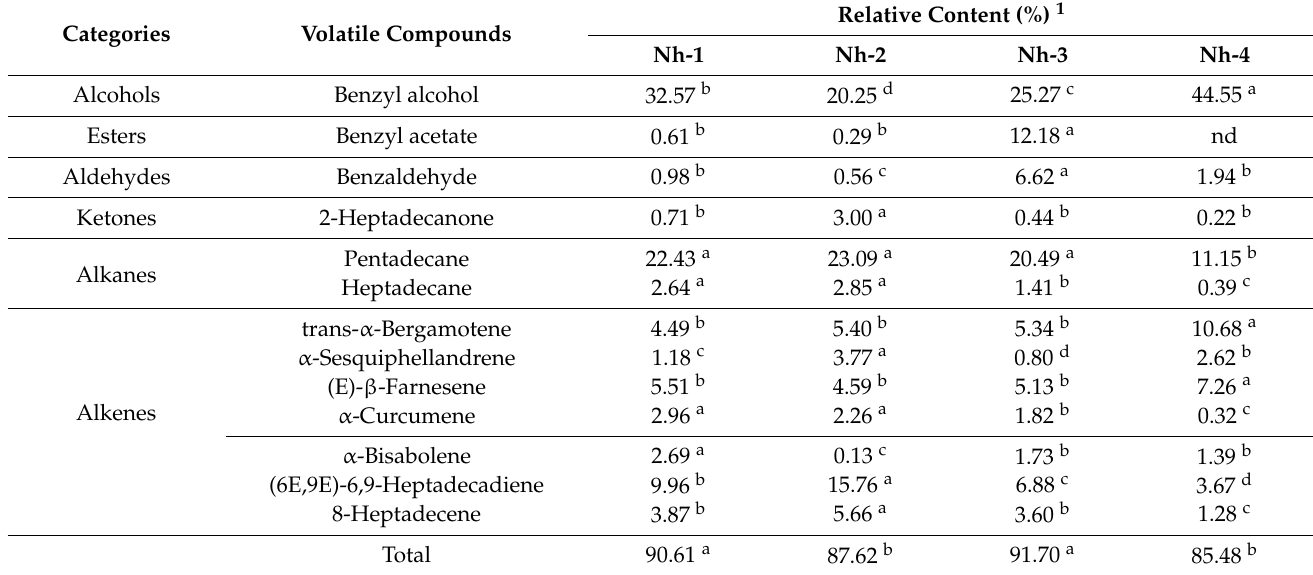
Table 2. Comparison of the main volatile compounds in N. hybrid